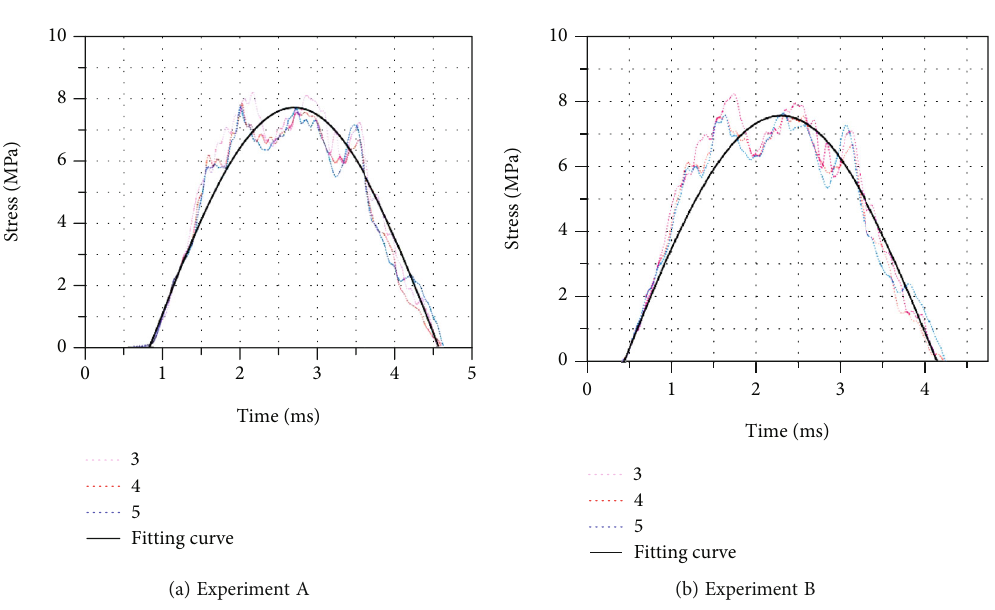
Figure 16: Stress curves of group